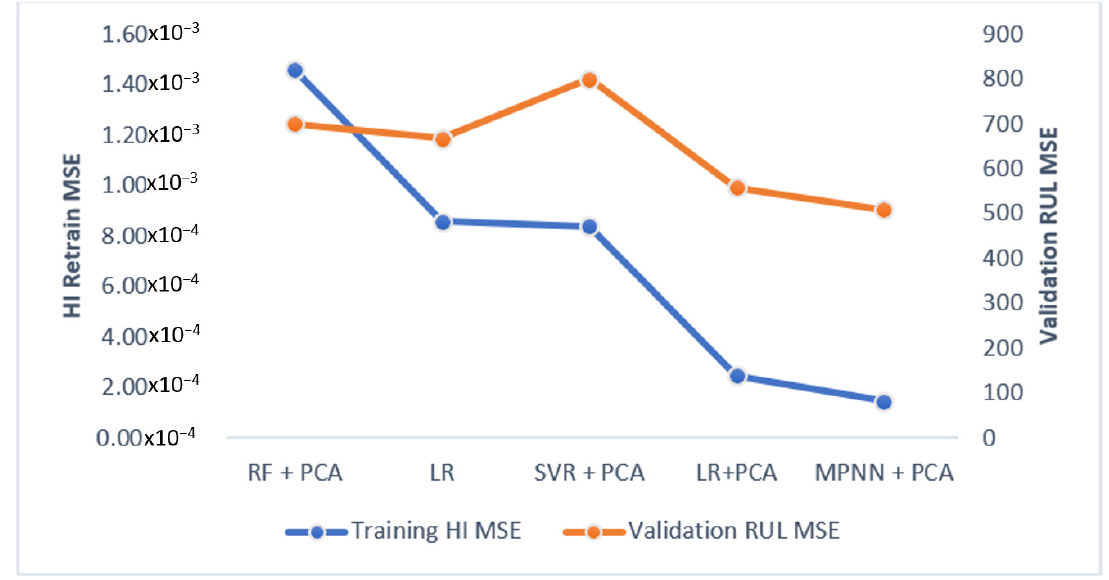
Figure 14. FD001_Test turbo unit 84 (172 cycles) test data validation.